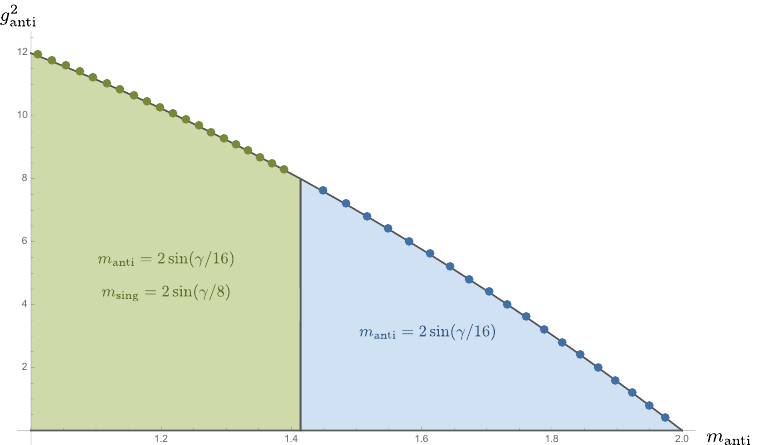
Figure 7 . Comparison between the N = 2 sine-Gordon kinks solution and numerical results. In the blue region corresponding to 4 (cid:25) < (cid:13) < 8 (cid:25) we impose one bound state in the anti-symmetric representation with mass m anti = 2 sin( (cid:13)= 16) and a zero S sing [ i ( (cid:0) (cid:25) + (cid:13)= 8)] = 0. In the green region where 8 (cid:25)= 3 < (cid:13) < 4 (cid:25) we keep the anti-symmetric bound state and impose a new bound state in the singlet representation with mass m sing = 2 sin( (cid:13)= 8) as well as a zero S sing [ i ( (cid:0) (cid:25) + (cid:13)= 2)] = 0. (We p avoid the point m sing = 2 because of our subtraction scheme.) The numerical points obtained with n grid = 40 match perfectly with the analytic solution (truncating the in(cid:12)nite product in (3.3) to 9) depicted in the grey